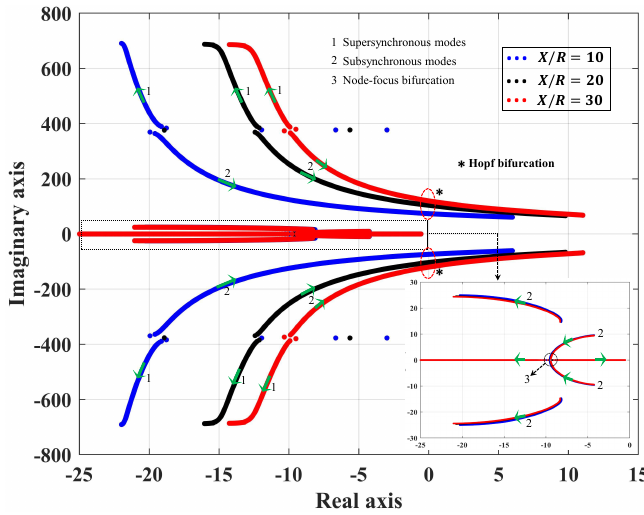
Figure 8. Eigenvalues with SVC for different grid